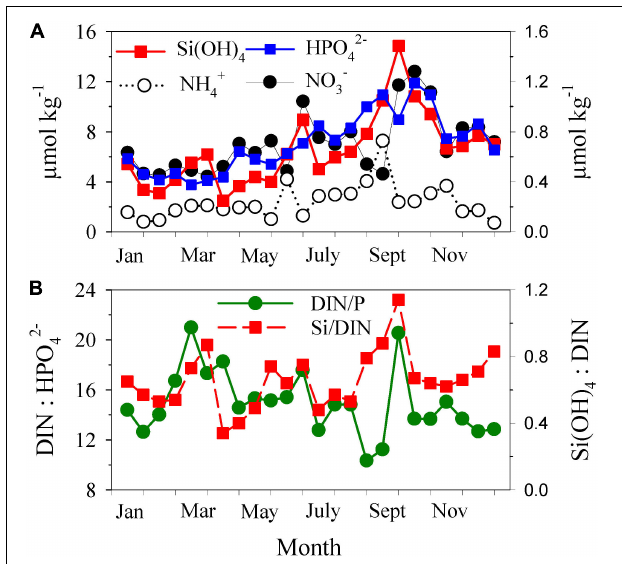
FIGURE 3 | Time series of (A) nutrient concentrations and (B) nutrient ratios [total dissolved inorganic nitrogen (DIN); phosphate (P); and silicate (Si)] in the bottom layer of the water column (40 m) In (A) silicate (Si(OH) 4 ), nitrate (NO − 3 ) and ammonium (NH + 4 ) are on the left axis, and phosphate (HPO 2 − 4 ) is on the right axis. In (B) DIN/P is on the left axis and Si/DIN is on the right axis. The values were averaged every half-month ( n = 3–5) to remove short-term